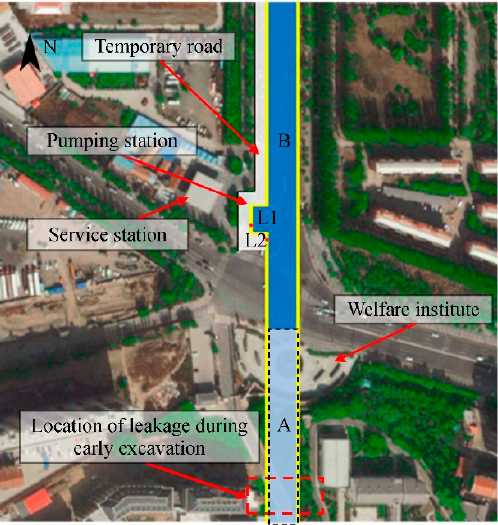
Figure 2. A plan view of the open pit excavation part of the project and layout of the instrumenta- tion.